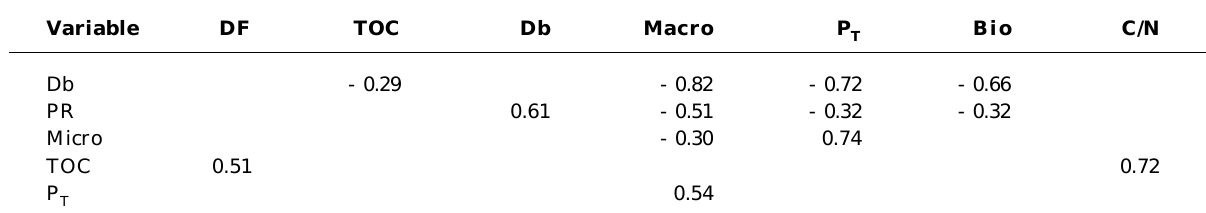
DF: degree of flocculation; TOC: total organic carbon; Macro: macroporosity; Micro: microporosity; P density; PR: penetration resistance; C/N: carbon/nitrogen. Only significant coefficients were presented (p < 0.05).